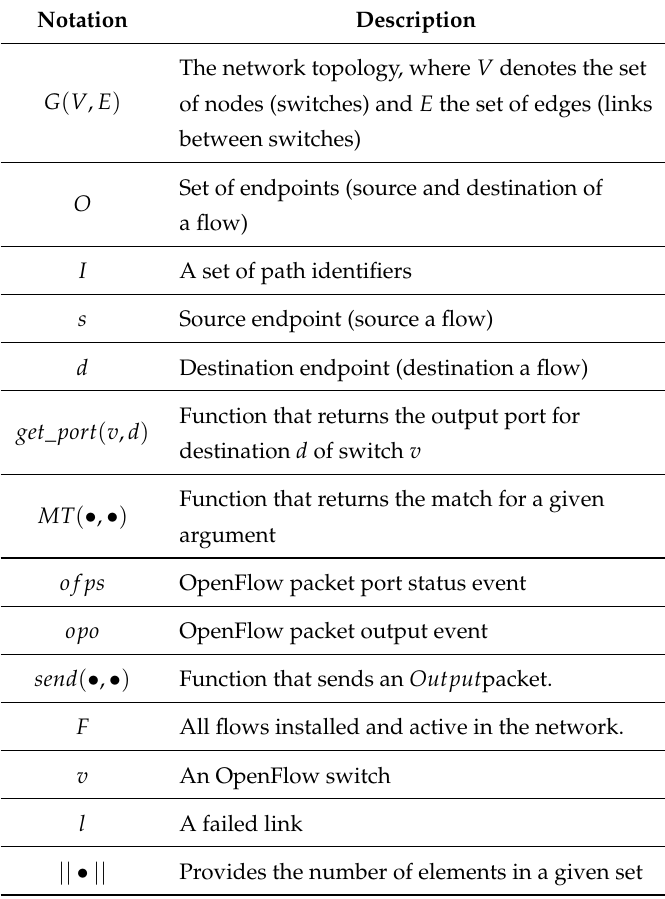
Table 2. Notation adopted.